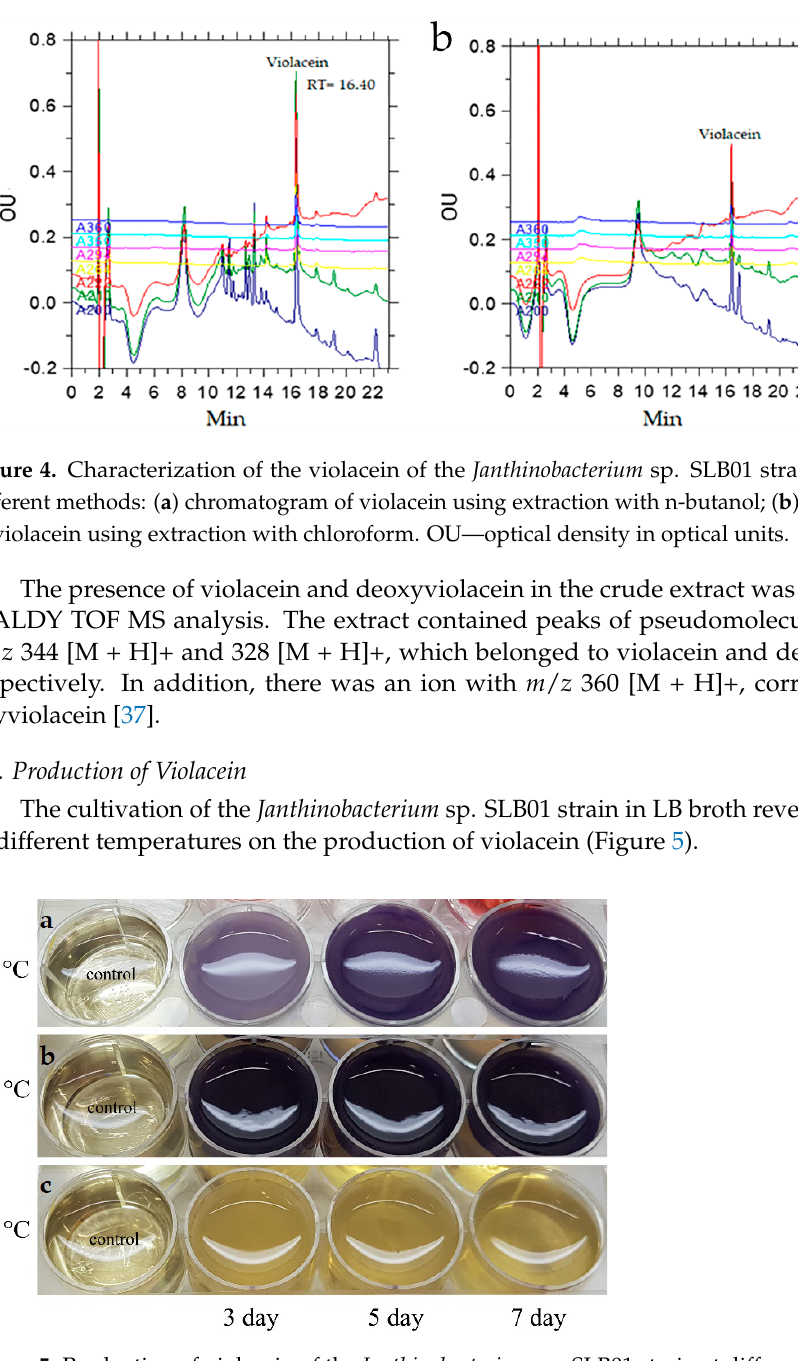
Figure 5. Production of violacein of the Janthinobacterium sp. SLB01 strain at different temperatures for five days. ( a ) Cultivation at 3 °C; ( b ) cultivation at 22 °C; ( c ) cultivation at 30 °C. The LB broth was taken as a control.